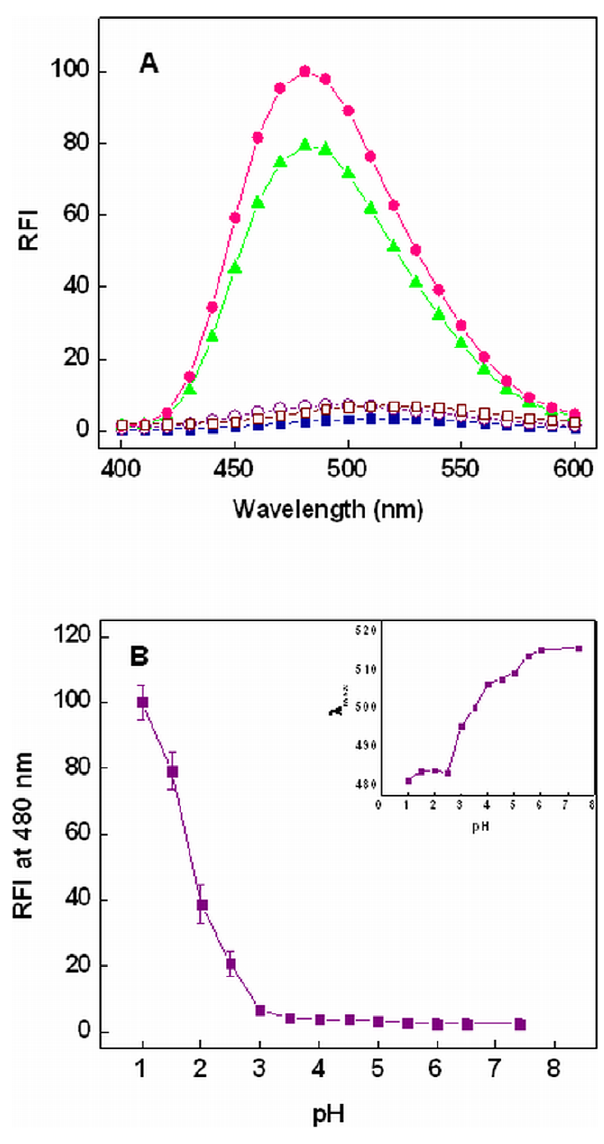
Figure 6. Effect of pH on ANS binding of chymopapain. (A) ANS N fluorescence spectra of chymopapain at pH 7.4 (- & -), pH 3.0 (- # -), -) and in the presence of 6M GuHCl (- % -). (B) pH 1.5 (- m -), pH 1.0 (- Changes in ANS fluorescence intensity of chymopapain as a function of pH at 480 nm. Inset: pH dependence of ANS emission maxima ( l max ) of chymopapain. Protein concentration was 8 m M. The molar ratio of protein to ANS was 1:50. doi:10.1371/journal.pone.0050633.g006 molecules bound to first and second set of sites respectively, D H1 and D H2 correspond to the enthalpy change associated with respective binding sites. The heat released D Q(i) from the ith injection for an injection volume dVi is given by: